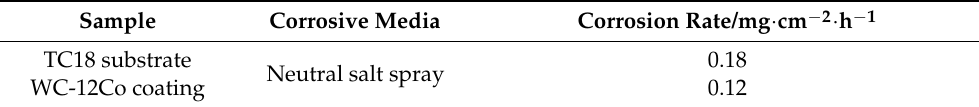
Table 10. The test results of neutral salt spray